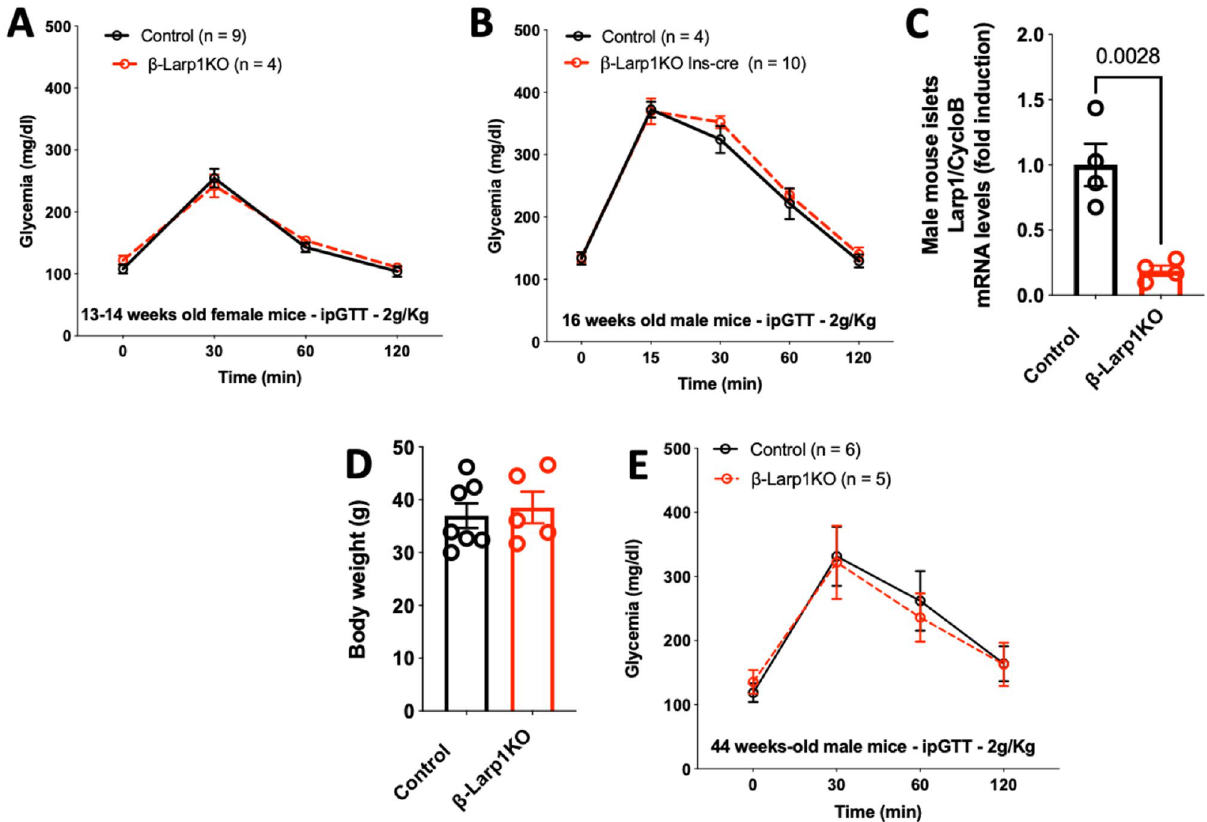
Figure 5. Female β-Larp1KO and old β-Larp1KO male mice are tolerant to glucose as control mice. ( A ) ipGTT in female β-Larp1KO mice and ( B ) ipGTT in male β-Larp1KO mice generated by crossing the floxed-Larp1 mice with the Ins1-cre mice instead of Rip-Cre used in Fig. 4. ( D ) Body weight and ( E ) ipGTT in male β-Larp1KO mice at 44 weeks of age. P value shown in ( C ) is compared to control mice assessed by Student’s T test.